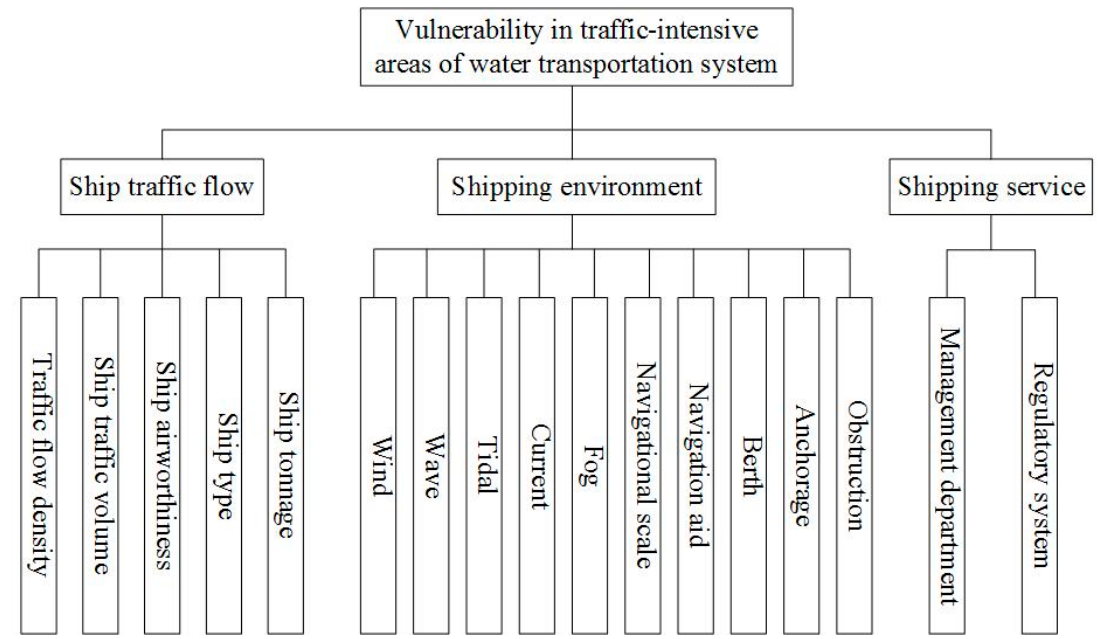
Figure 2. Vulnerability factors of a water transportation system in traffic-intensive waters.